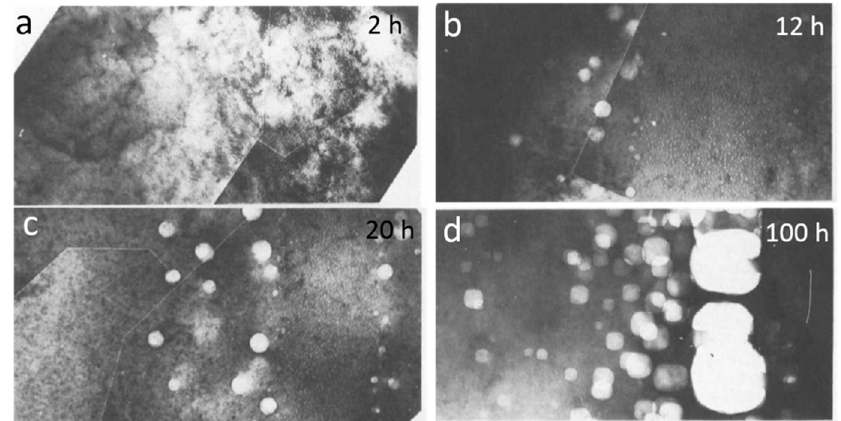
Figure 6. He bubbles in Ni implanted with 1 × 10 17 ions cm − 2 at 500 keV, annealed at 750 °C for: ( a ) 2 h; ( b ) 12 h; ( c ) 20 h; and ( d ) 100 h. He bubbles size increases with increasing annealing time. Reprinted with permission from [57]; Copyright 1987 Elsevier.